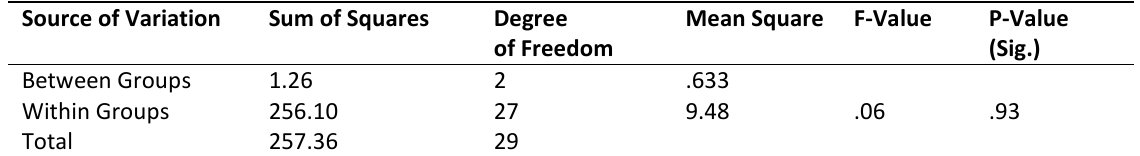
Table 15. One way analysis of variance (Anova) results among judo, taekwondo and boxing players with regard to the sub-parameter prayer Source of Variation Sum of Squares Degree Mean Square F-Value P-Value of Freedom (Sig.) Between Groups 1.26 2 256.10 257.36